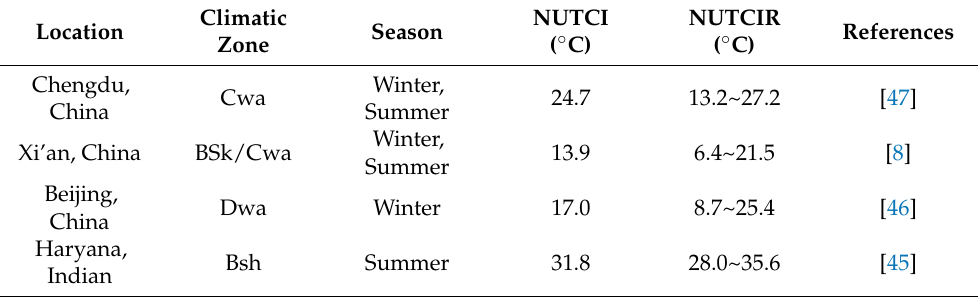
Table 8. NUTCI and NUTCIR in other outdoor thermal comfort studies. NUTCI Climatic Season Location ( ◦ C) Zone